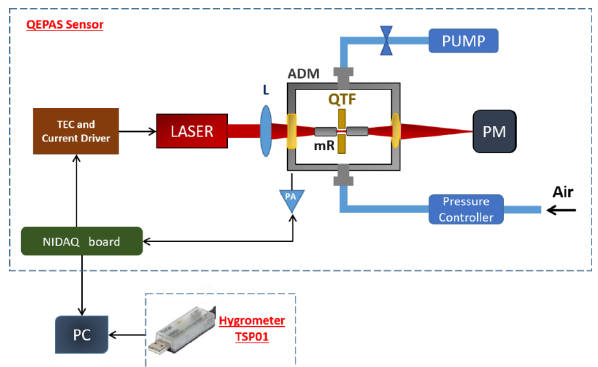
Figure 1. Schematic of the sensor setup for methane and water vapor detection including a quartz-enhanced photoacoustic spectroscopy (QEPAS) module and a hygrometer. ADM, acoustic detection module; QTF, quartz tuning fork; mR, microresonators; L, focusing lens; PM, power meter; PA, preamplifier; NIDAQ board, National Instruments data acquisition board; PC, personal computer.